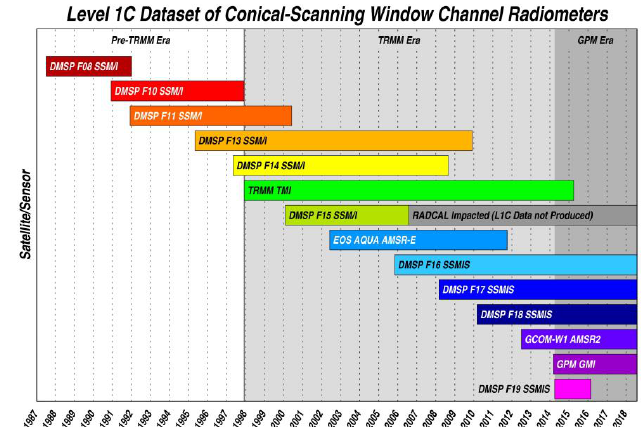
Figure 2. The availability of Level 1C data from a total of 14 conical-scanning microwave imagers. The light gray shaded region corresponds to the TRMM era and the dark gray region to the GPM